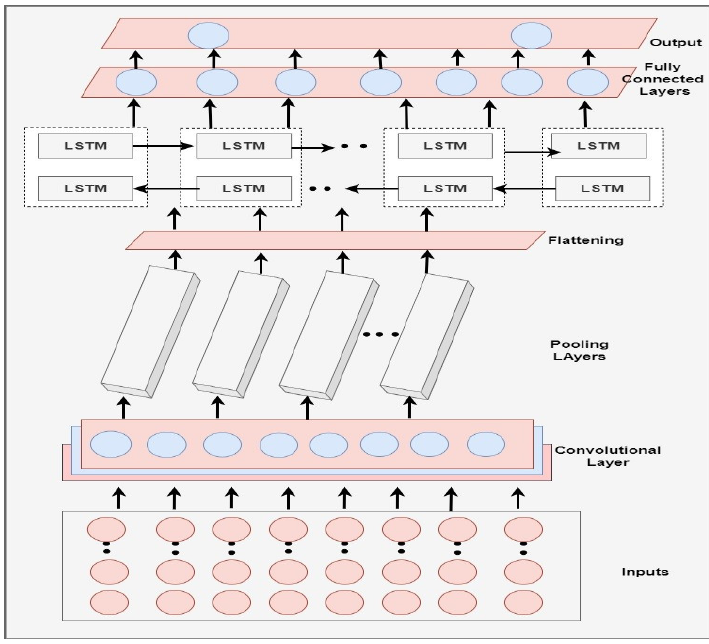
Figure 6. Architectural CNN-Bi-LSTM Model for Diabetes Prediction.